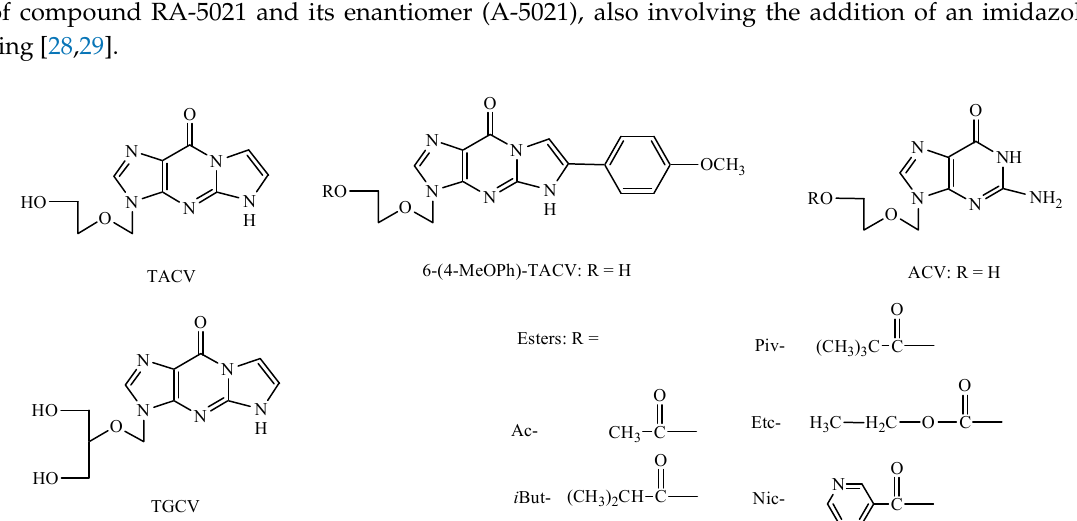
Figure 1. The chemical structure of 3,9-dihydro-3-[(2-hydroxyethoxy)-methyl]-9-oxo-5 H -imidazo[1,2- dihydroxy-1,2- a ]purine derivatives as a modification of acyclovir (TACV), ganciclovir (TGCV), and the testedestersof3,9-dihydro-3-[(2-hydroxyethoxy)methyl]-6-(4-methoxyphenyl)-9-oxo-5 H -imidazo[1,2- a ] –purine (6-(4-MeOPh)-TACV) and acyclovir